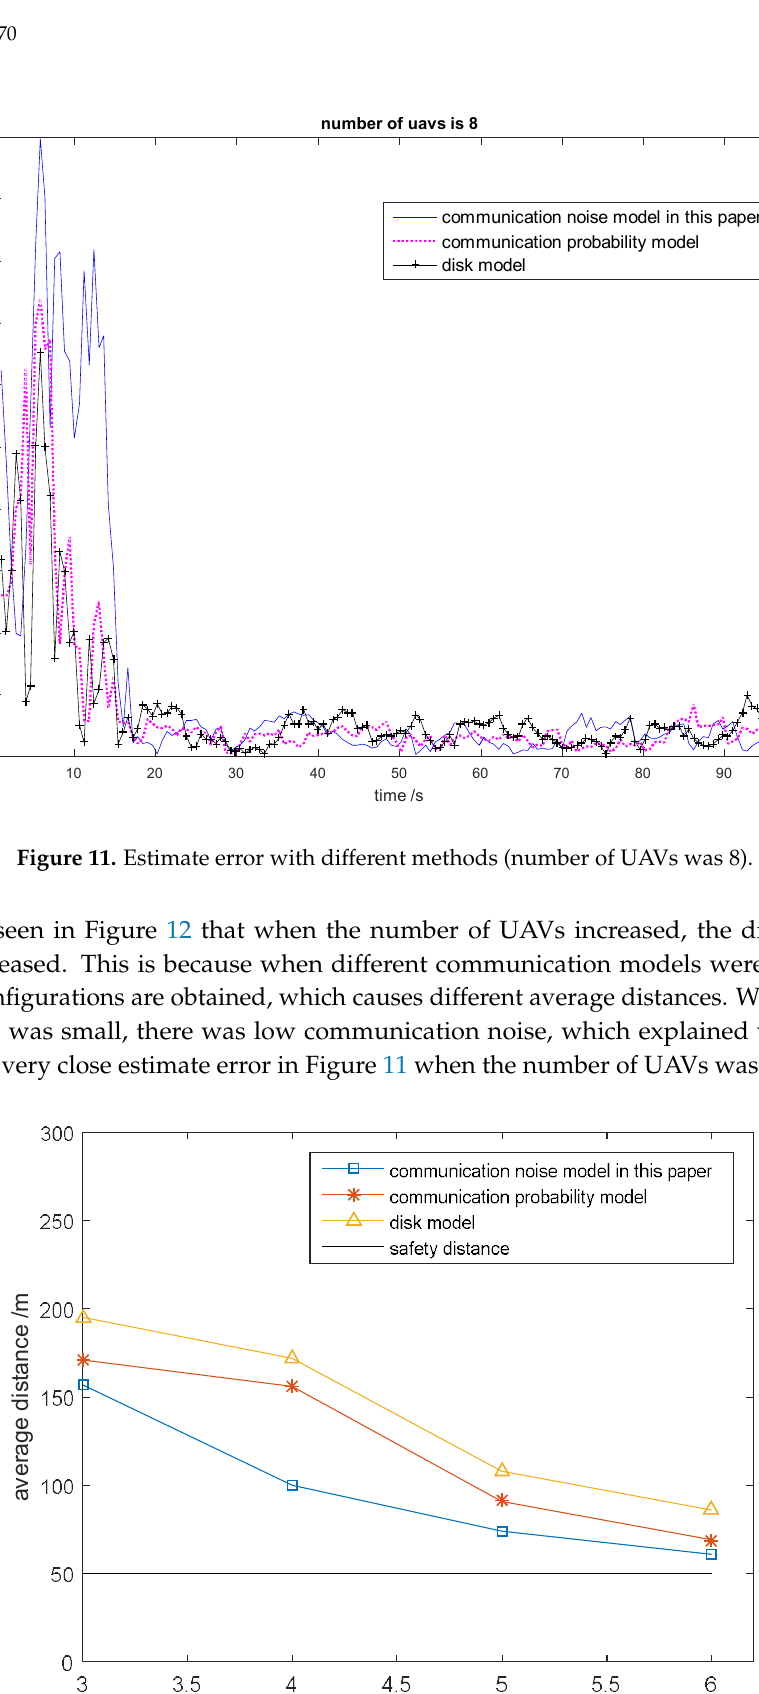
Figure 12. The impact of number of UAVs.